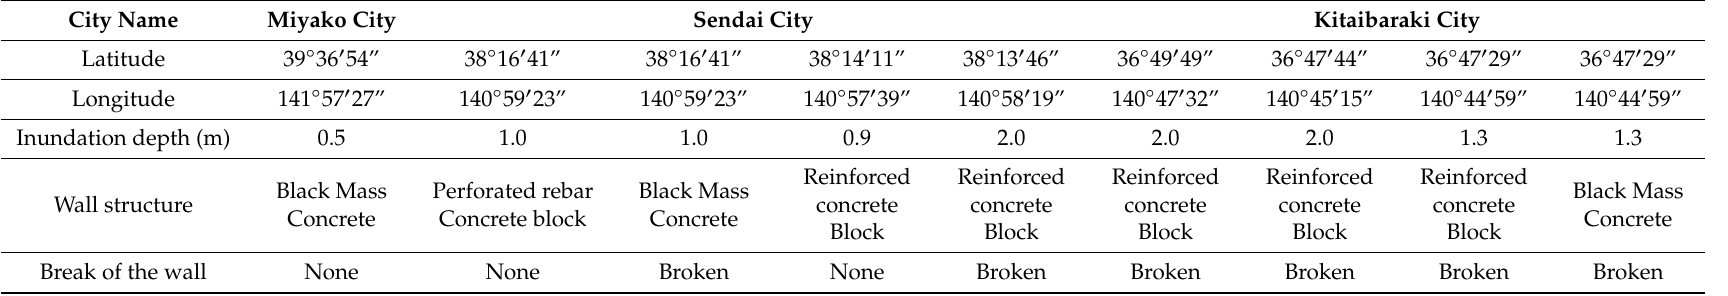
Table 4. Survey on damage to concrete block walls during the 2011 Great East Japan Earthquake